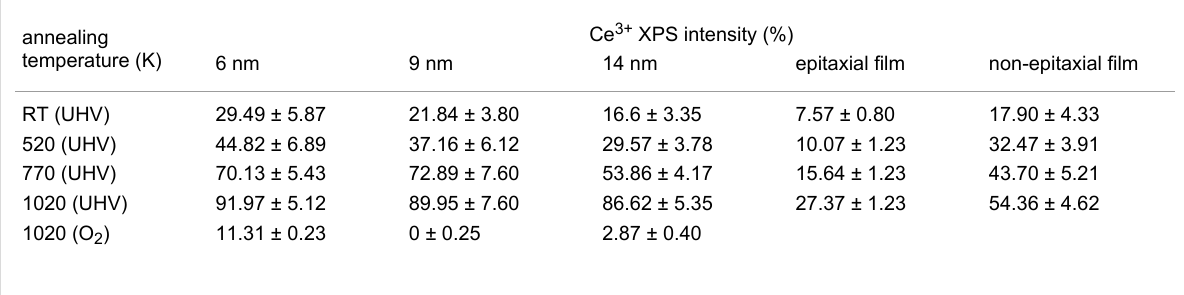
Table 2: Ce 3+ XPS intensity resulting from the fitting of the XPS spectra acquired at different annealing temperatures for NPs with different size and ultra-thin films under reduction and oxidation conditions.